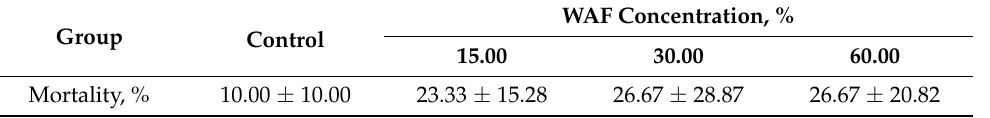
Table 3. Mortality rate of marine medaka embryos after 21 d of exposure in chronic test ( n = 3).